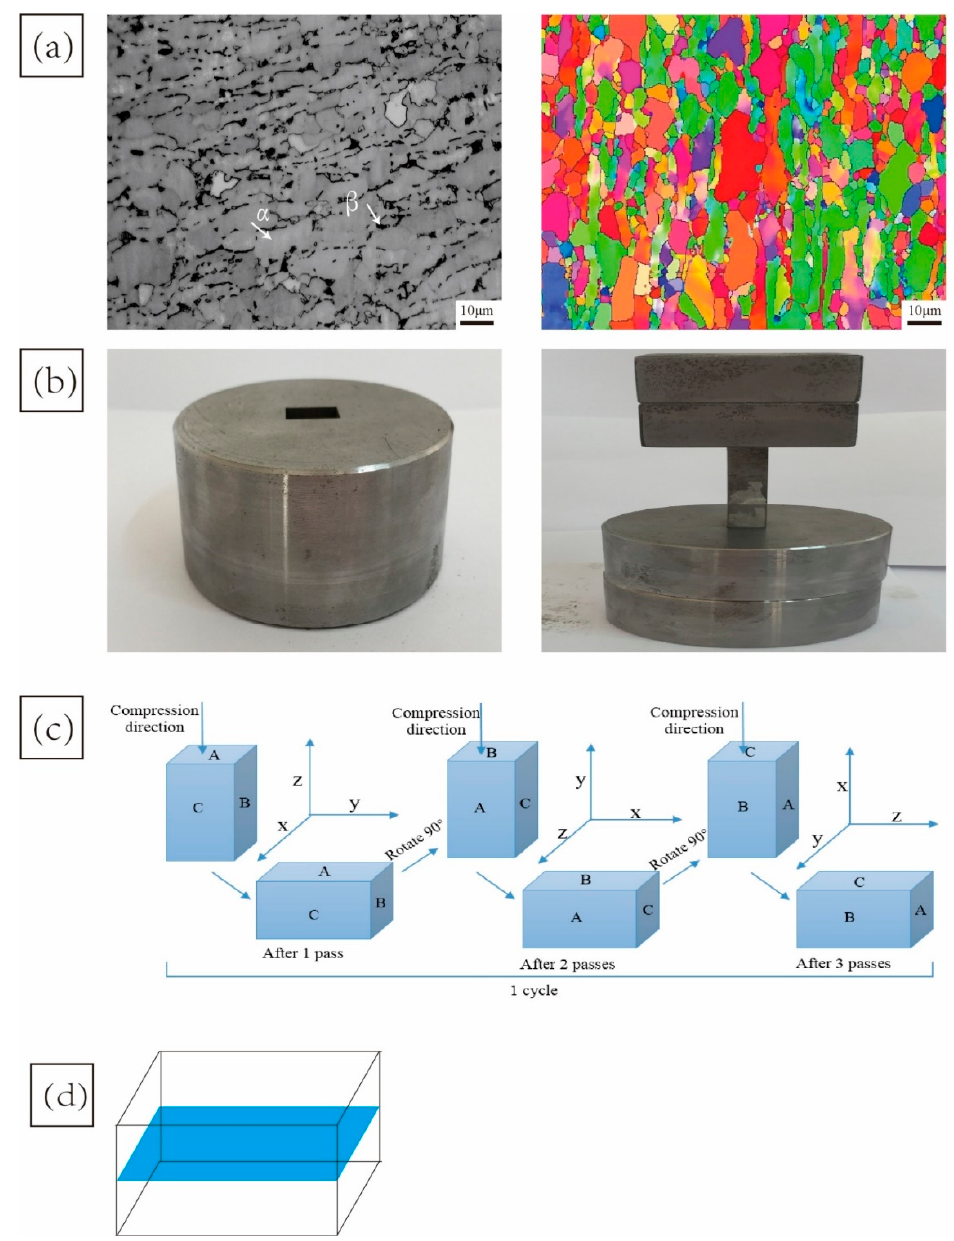
Figure 1. Initial structure of TC4 alloy and schematics showing the die and the coordinate systems: ( a ) initial structure of TC4 alloy; ( b ) MDIF die; ( c ) MDIF process diagram; ( d ) sampling position diagram.